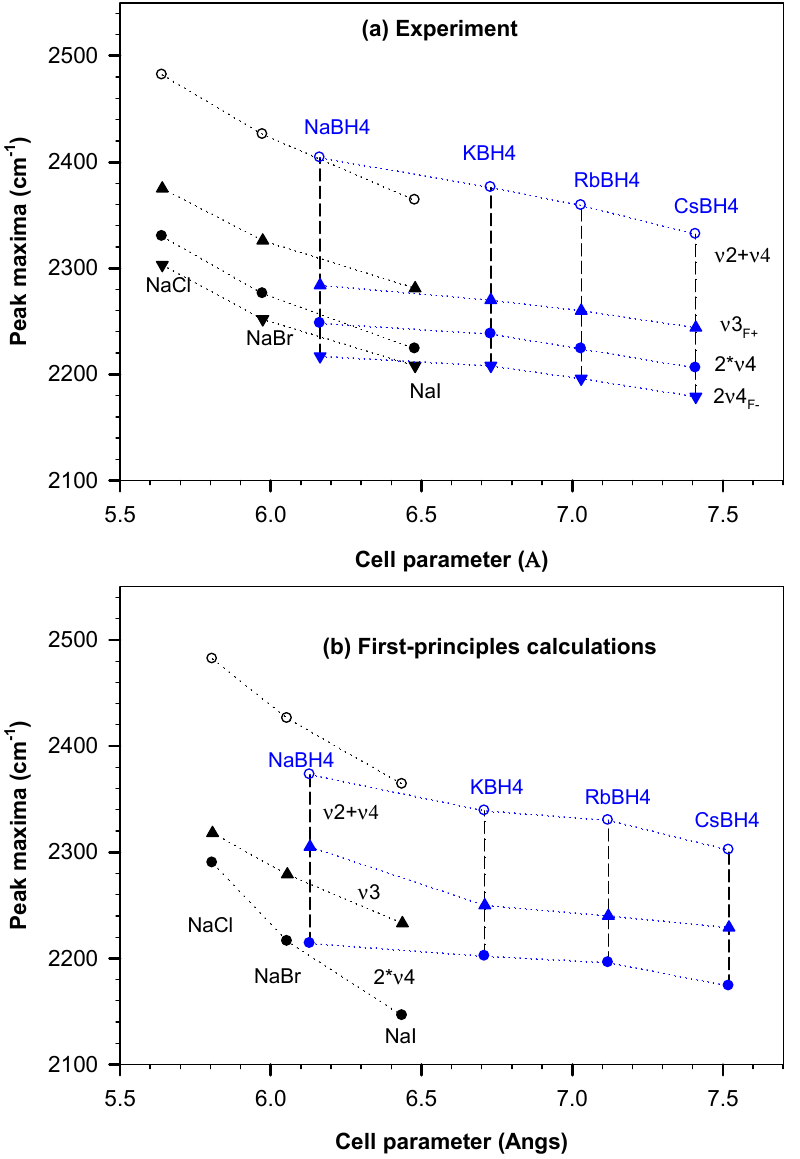
Figure 7. ( a ) Experimental peak positions of v 4 expressed in the term of 2*v 4 , 2v 4F − , v 3F+ ( F − , F+ denotes the Fermi − resonance effect) and v 2 + v 4 of i-BH 4 − in NaX, X = Cl, Br, I and MBH 4 (taken from Renaudin et al. [32]) as a function of the cell parameter a 0 . ( b ) Calculated (first principles) peak positions of BH 4 − anion in Na(BH 4 ) 0.25 X 0.75 with X = Cl, Br, I and MBH 4 , M = Na, K, Rb, Cs as a function of calculated unit cell